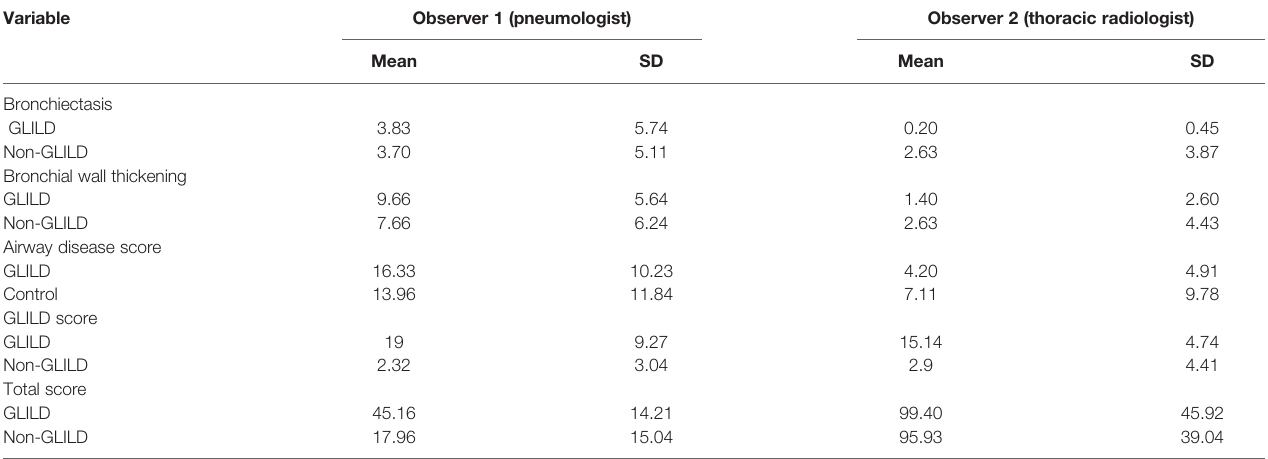
TABLE 5 | Differences in the observers ’ fi ndings in Baumann ’ s composite